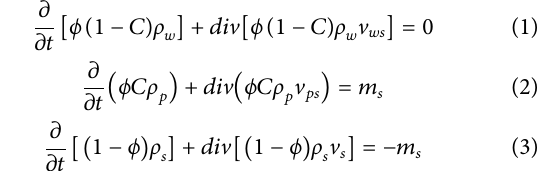
FIGURE 2 | Illustration of the test.